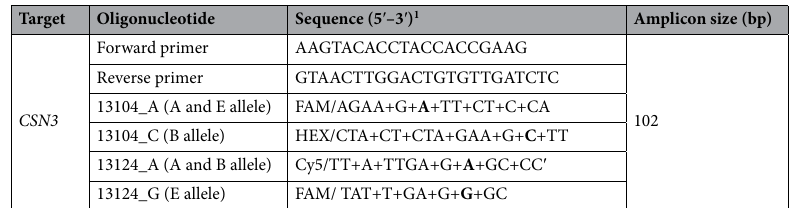
Table 2. Primers and locked nucleic acid (LNA) probes used in the duplex qPCR assay. 1 LNA bases are represented by “+” and the detected polymorphism in bold.